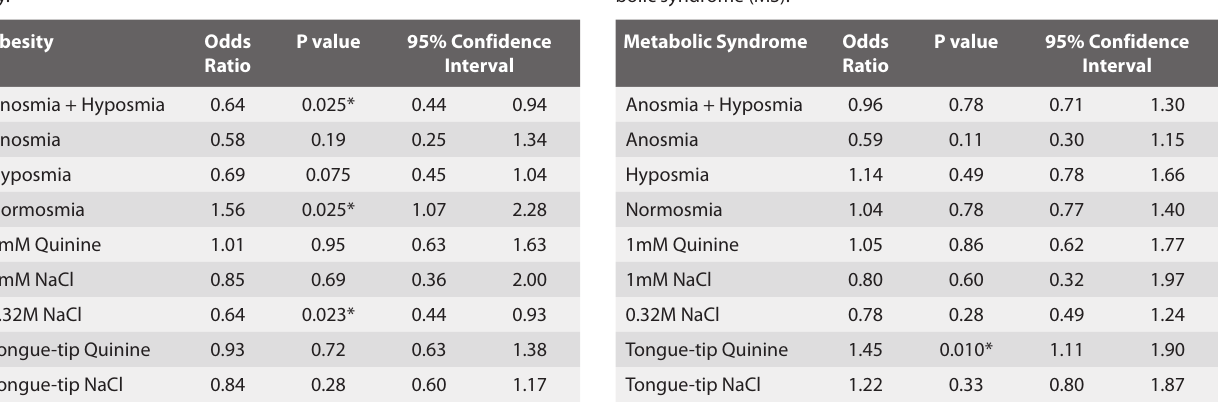
Table 3. Univariate analyses of smell and taste dysfunction versus meta- bolic syndrome